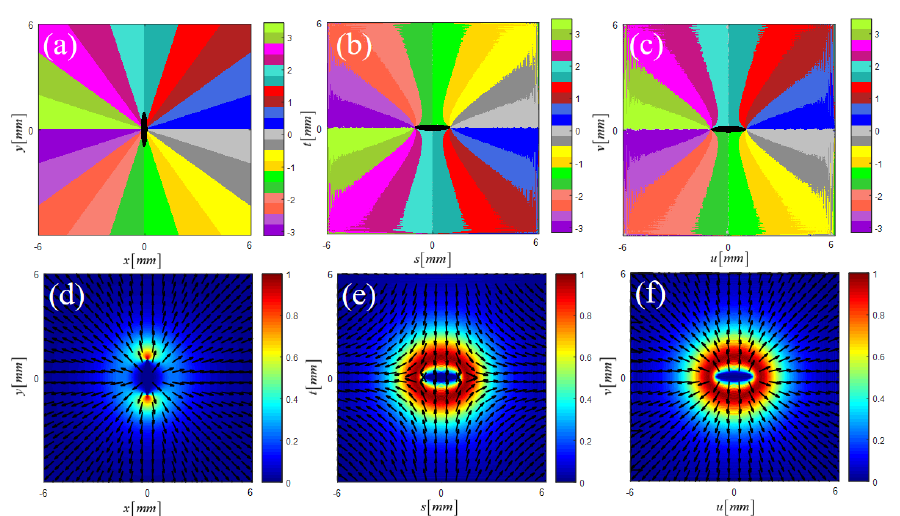
Figure 8. Simulation results displaying the generation of ESRP beam. ( a – c ) Polarization-angle color map on the Z − , Q − , and W − planes, respectively; ( d ) depicts the input beam; ( e ) depicts the beam in the intermediate plane Q ; ( f ) depicts the ESRP